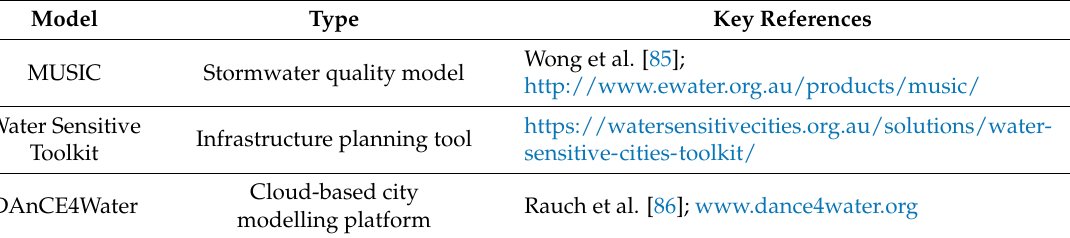
Table 3. Overview of Water Sensitive City (WSC) Tools